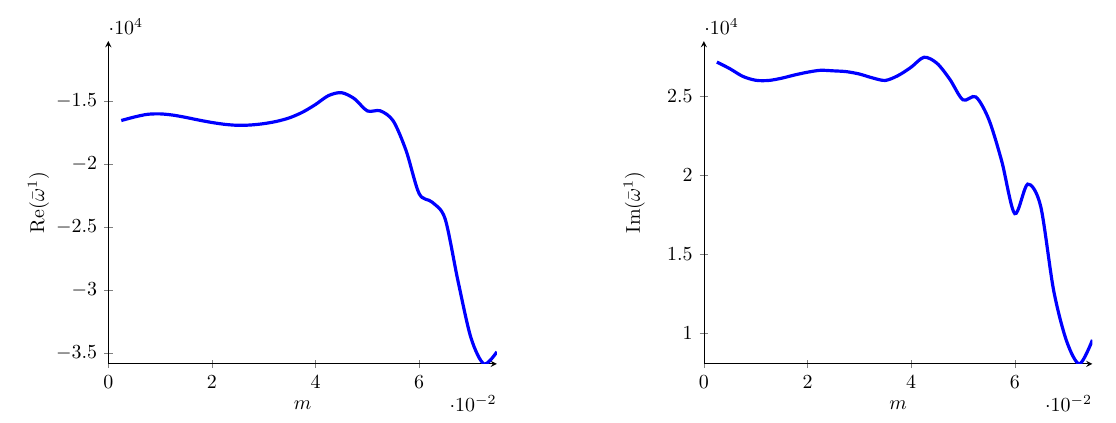
Figure 6 . The convergence of (cid:22) ! 1 ( m ) for di(cid:11)erent interval sizes [0 : 1 + m; 0 : 99 (cid:22) ! 1 ( m ) is de(cid:12)ned as the point of convergence of the M -dependent sequence ^ ! 1 ( M; m; m ) with (cid:12)xed m